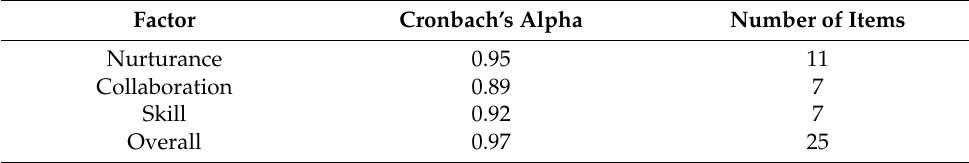
Table 4. Cronbach’s alpha for each factor of the CDI.